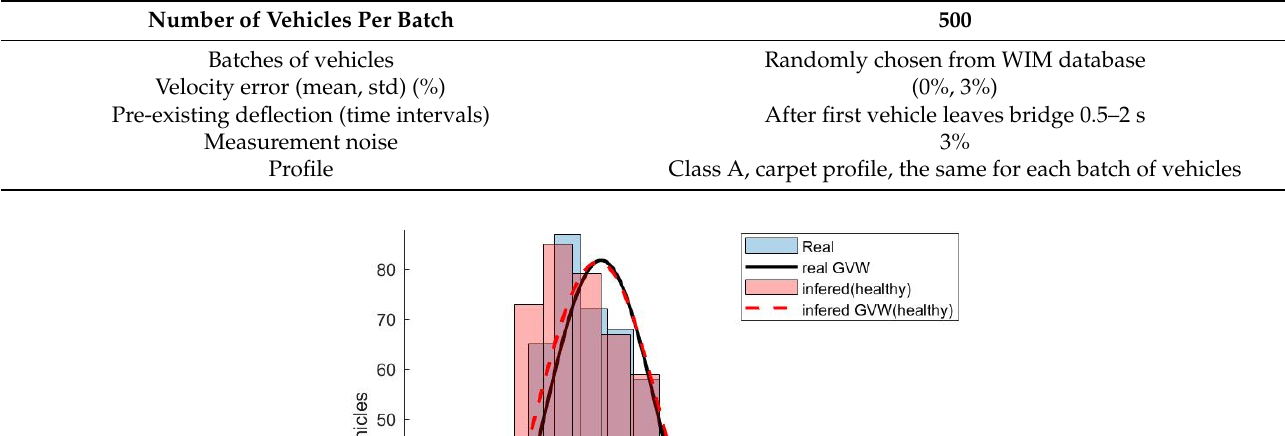
Table 5. Variables in simulation.